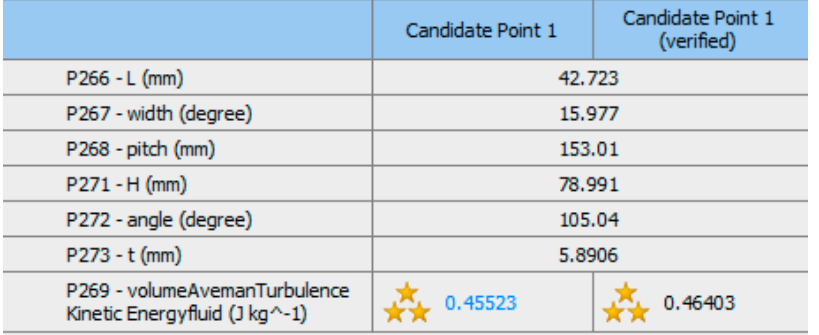
range of design parameters.